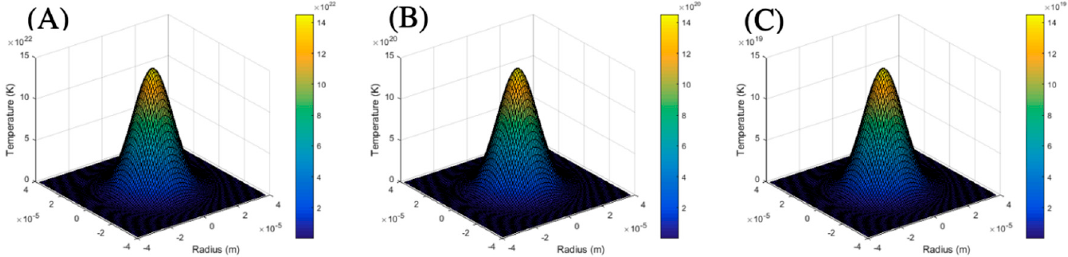
Figure 5. The 3D temperature gradient profile for ( A ) laser frequency of 600 kHz; ( B ) laser frequency of 800 kHz; and ( C ) laser frequency of 1200 kHz.